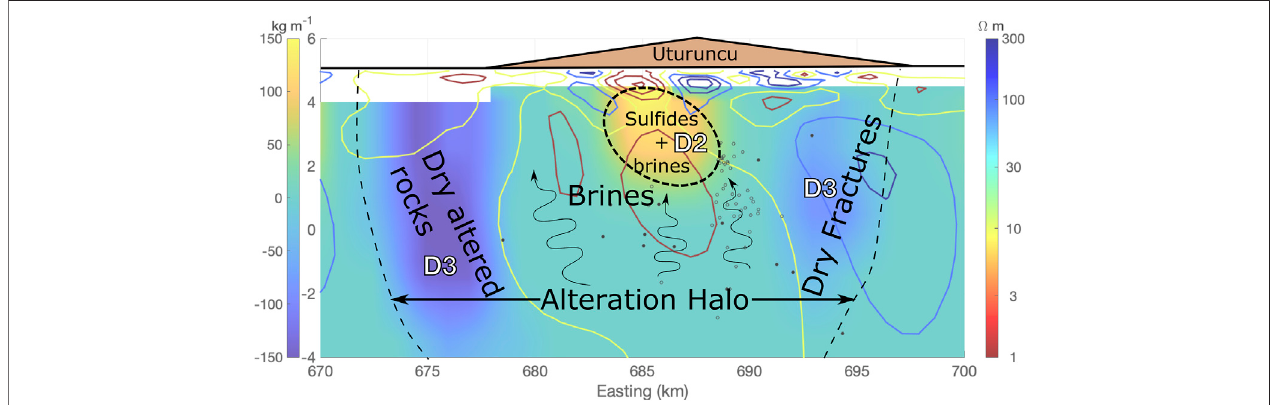
FIGURE 11 | Conceptual model of subsurface structure at Uturuncu from joint interpretation of density and resistivity models. The cross section cuts W-E at the peak of Uturuncu (Northing (cid:1) 7,536), with the resistivity model (colored contours) overlaid on the density model as in Figure 8 . Small circles represent earthquake hypocenters within 500 m of the slice from Hudson et al. (2021). An alteration halo consisting of brines (low resistivity, negative to neutral density contrast), altered rocks (low density), brines (low resistivity), and dry fractures (negative density contrast, high resistivity) surrounds a shallow zone of sul fi de deposition (low resistivity, positive density contrast) beneath Uturuncu. Arrows indicate possible fl uid movement, inferred from earthquake locations, in zones with brines.